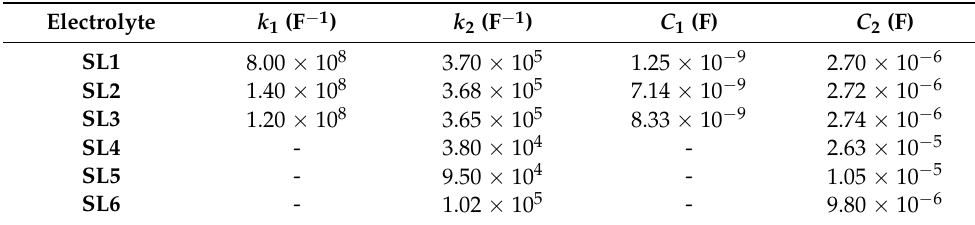
Table 5. Room temperature circuit elements for the salted electrolytes.